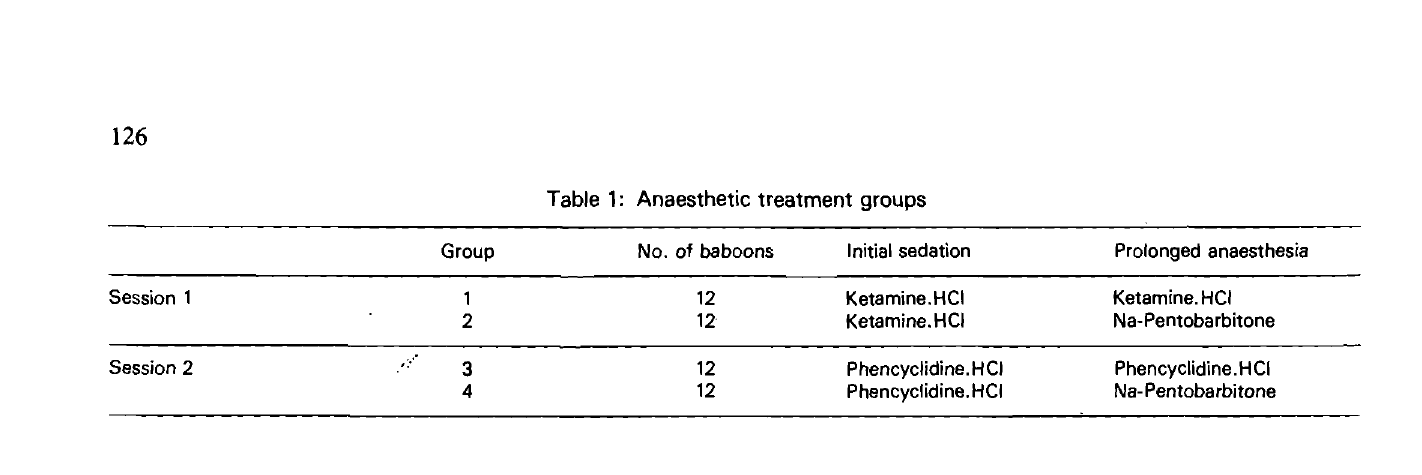
Table 1: Anaesthetic treatment